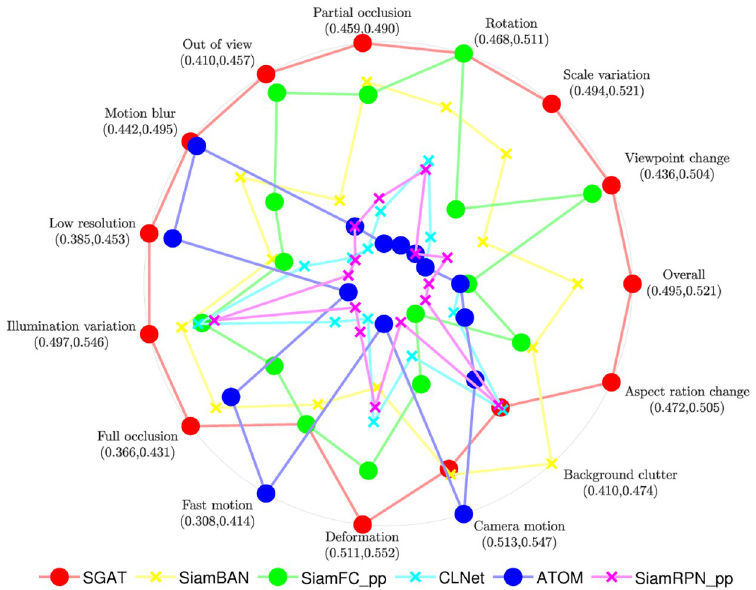
Fig 7. Comparision with different trackers on each attribute of LaSOT. SiamFC_pp and SiamRPN_pp represent trackers SiamFC++ and SiamRPN++, respectively.